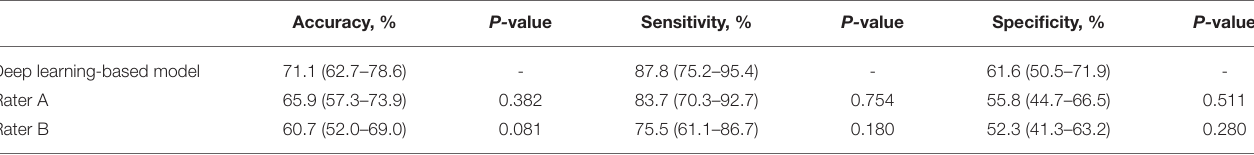
TABLE 2 | Classification results.